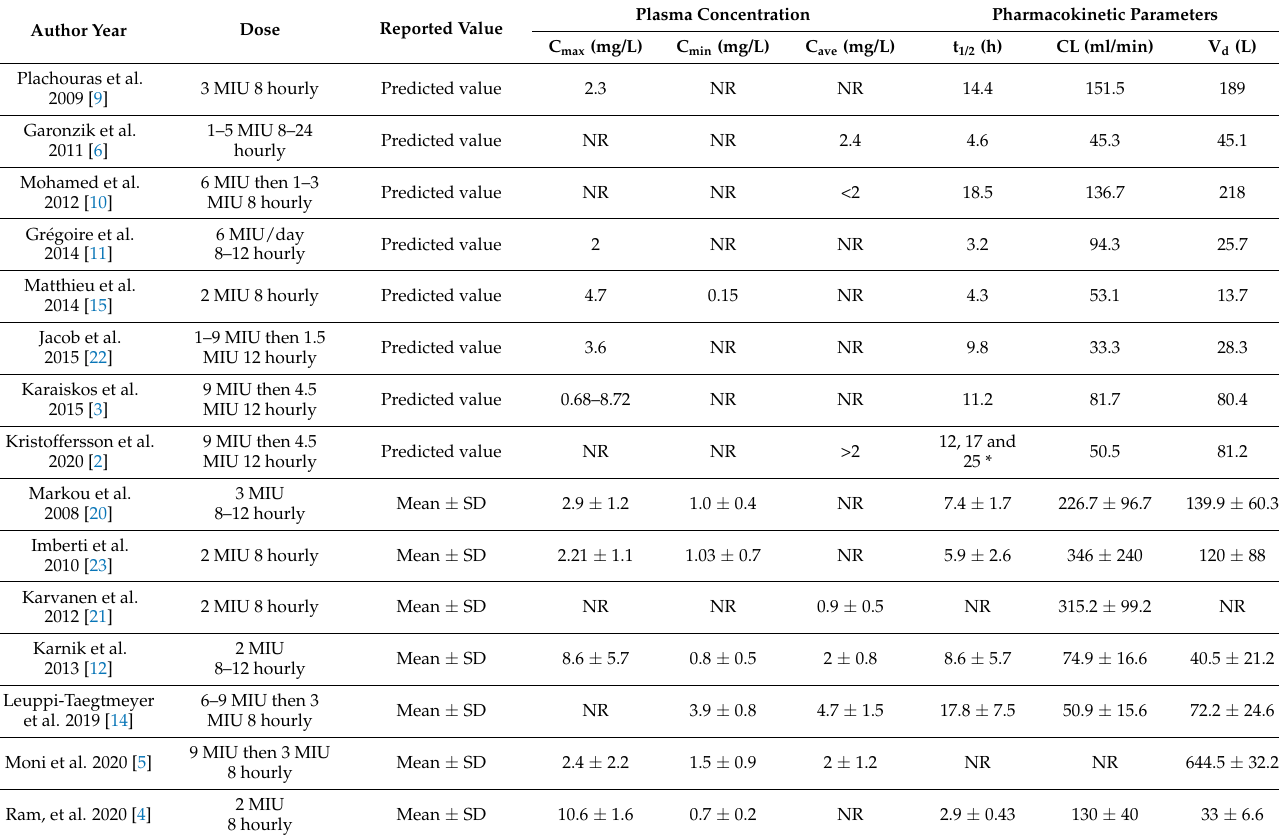
Table 4. Comparison of colistin pharmacokinetics parameters in plasma at steady state.